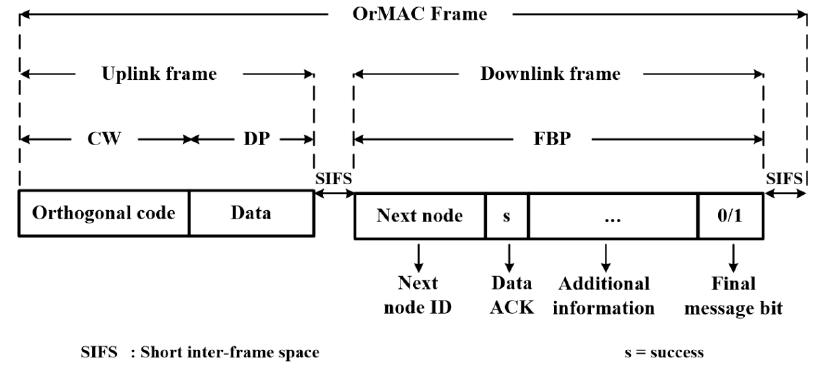
Figure 1. Structure of a single or thogonal coded m edium a ccess c ontrol (OrMAC) frame.